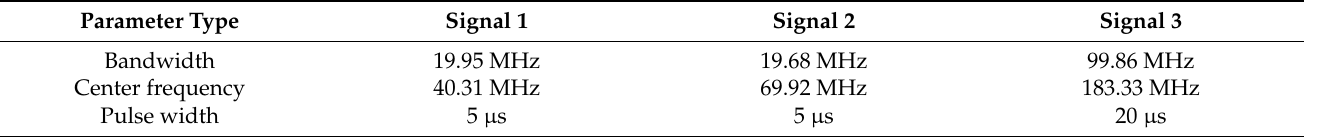
Table 4. The estimated